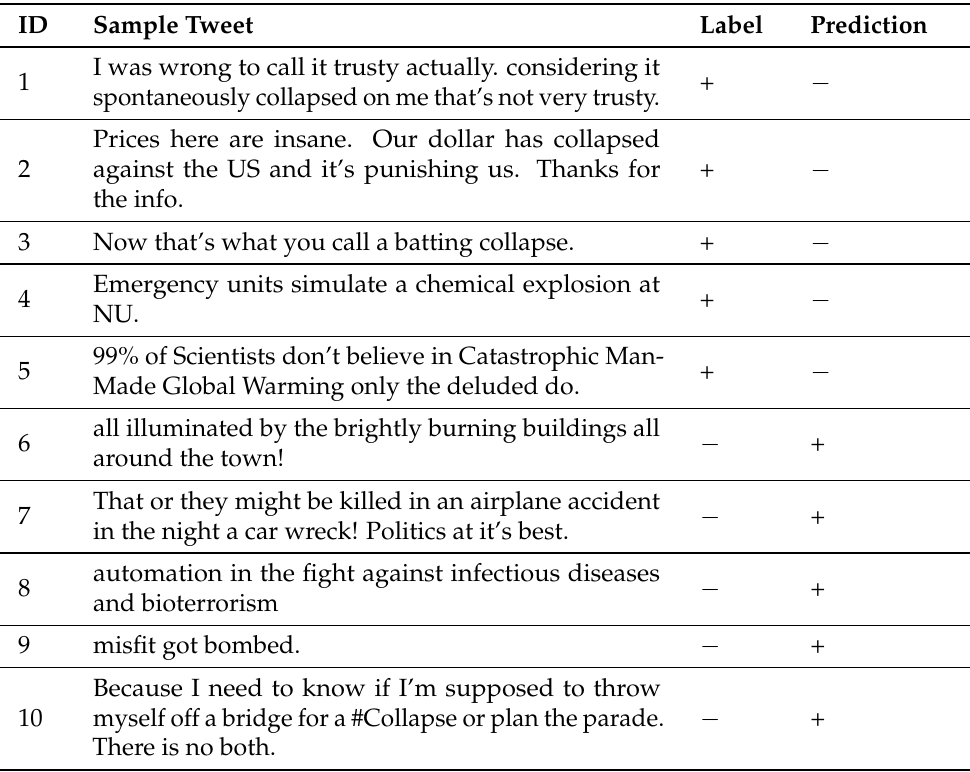
Table 5. Examples of misclassified samples. A “+” sign indicates a positive sample, and a “ − ” sign indicates a negative